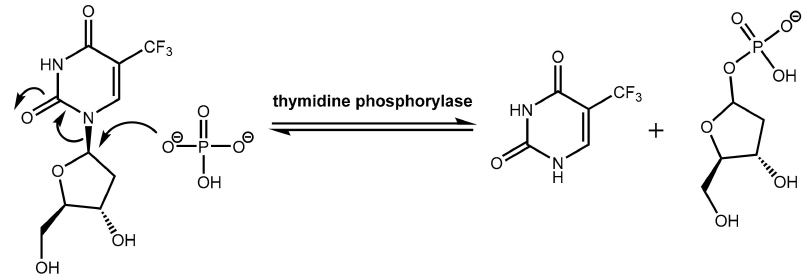
Figure 22. Inactivation of trifluridine catalyzed by the enzyme thymidine phosphorylase.